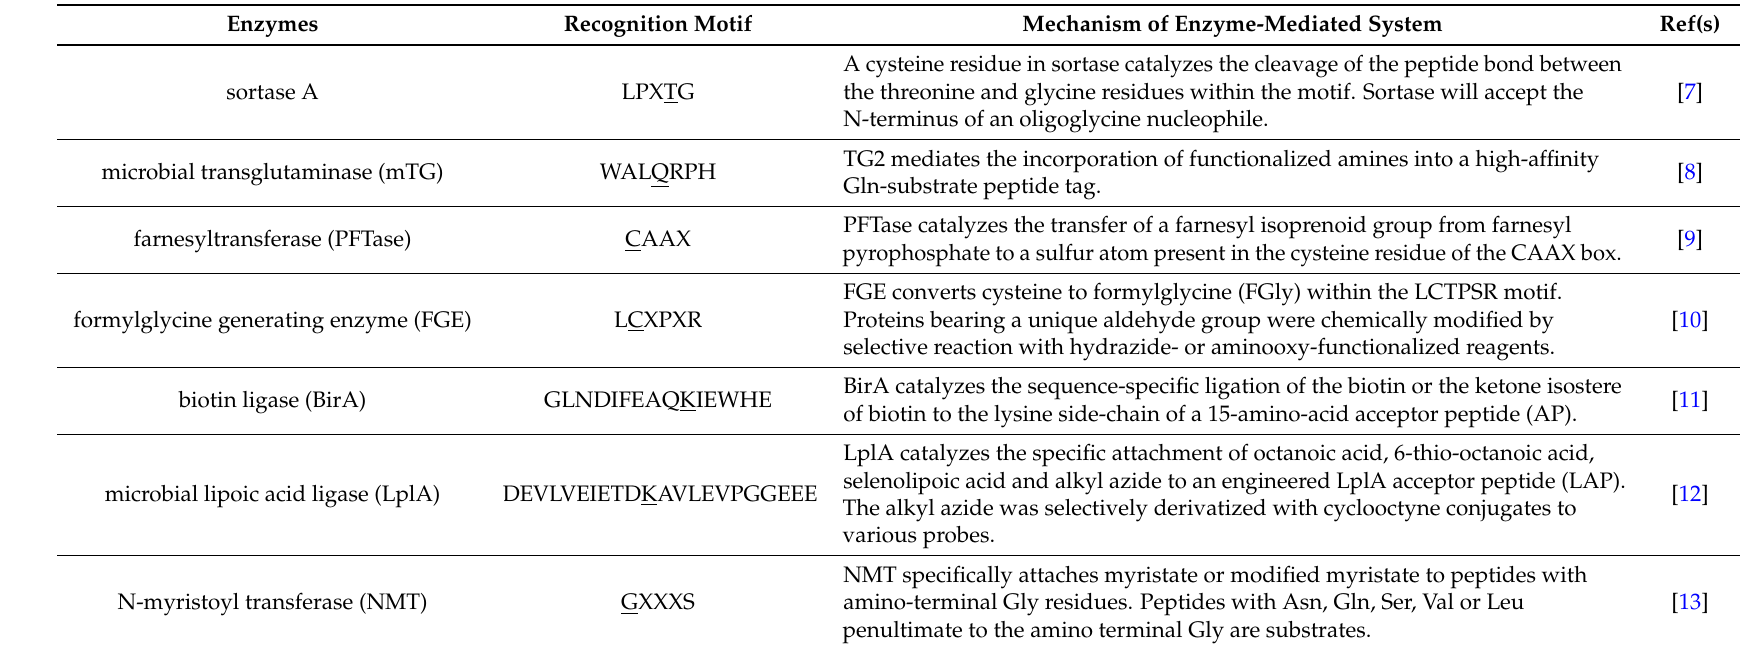
Table 1. Enzymes-mediated systems used in protein